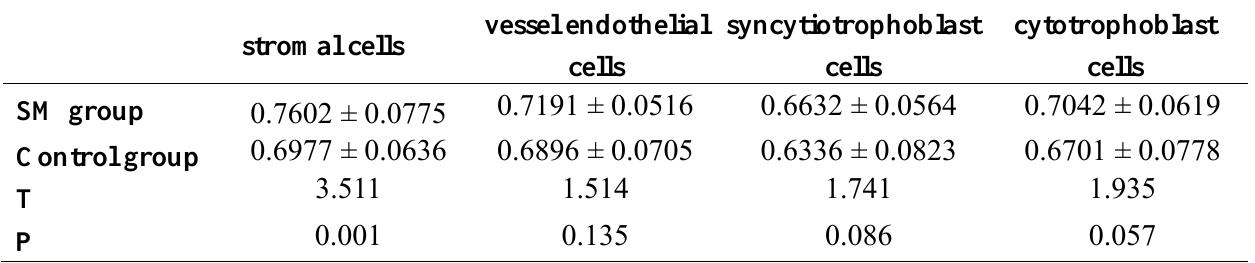
Table 3. The level of the nucleoplasmic ratio of NF- κ B p65 (mean ± s) in the different cells in villous.